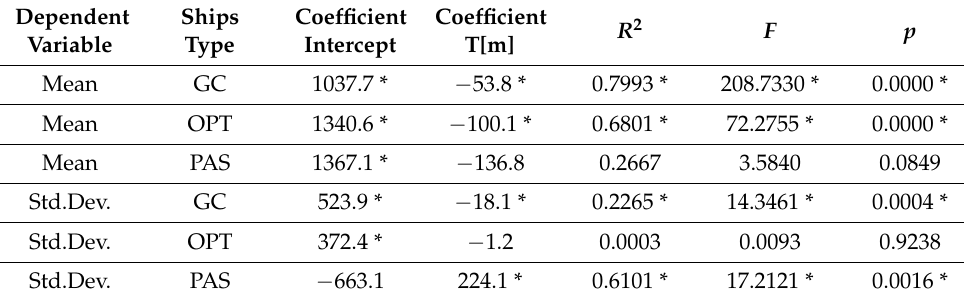
Figure 9. Mean of ships distance from the centre to the width of the ship.